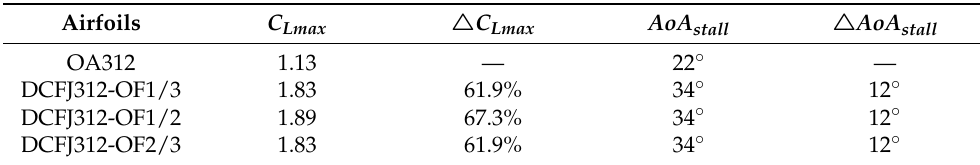
Table 8. Comparisons of maximum lift coefficients and stall AoA s of DCFJ312 airfoils with various OF s.